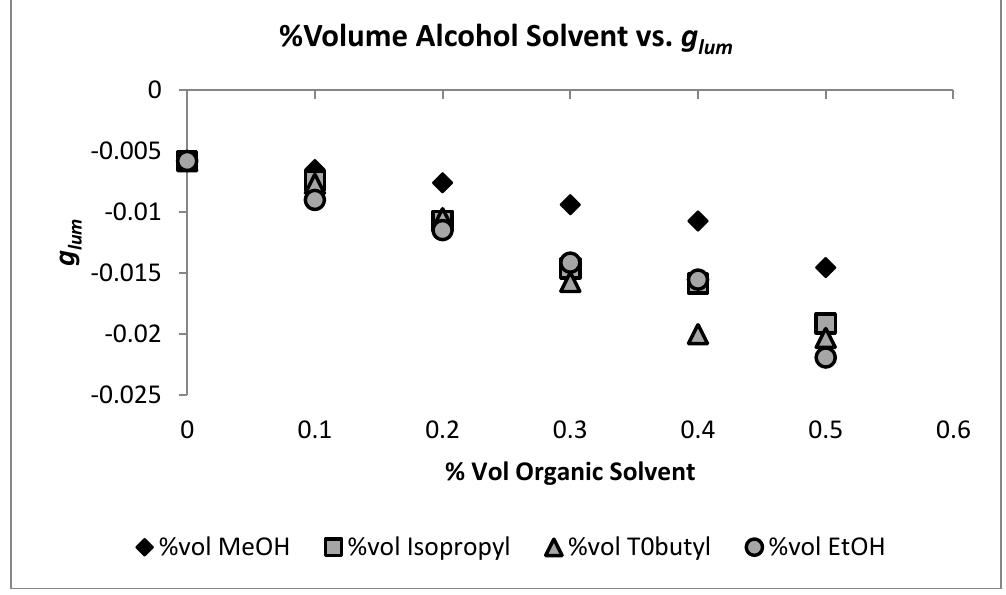
Figure 5. Plots of luminescence dissymmetry values ( g lum ) of [Tb(DPA) 3 ] 3− with varying ratios of either methanol (diamonds), ethanol (circle), isopropyl alcohol (square), or t -butyl alcohol (triangle). Ratios are varied from 90:10 to 50:50 H 2 O:alcohol solvent. Table 3. Luminescence dissymmetry ratio values ( g lum ) for H 2 O:alcohol solvents. g lum for Each H 2 O:Solvent Ratio a